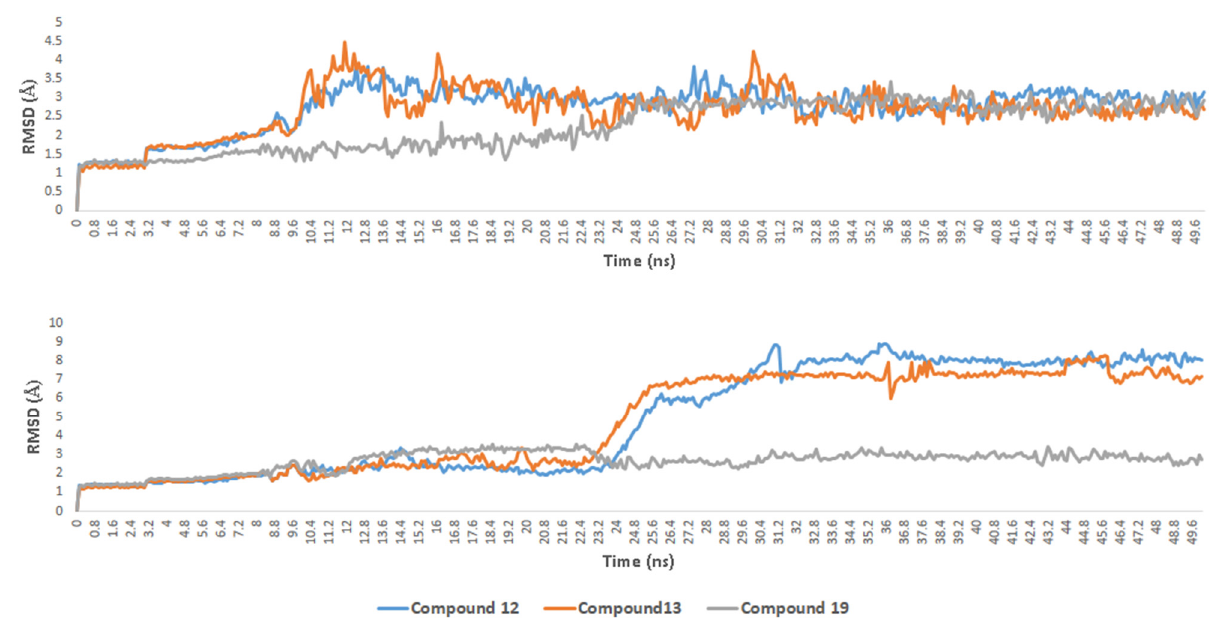
Figure 7. RMSDs of compounds 12 , 13 and 19 inside 5-LOX and 15-LOX’s active sites over 50 ns of molecular dynamic simulations (MDS).